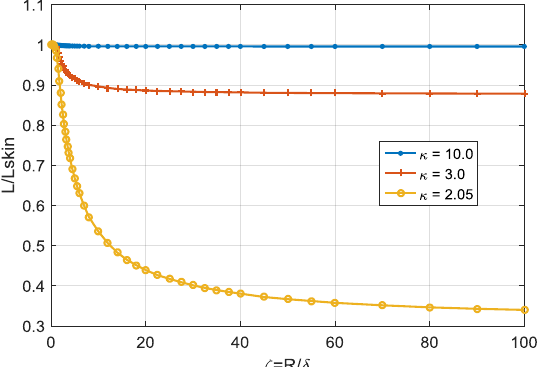
Figure 2: The final ratio 𝐿/𝐿 𝑠𝑘𝑖𝑛 in function of 𝜁 for 𝜅 = 10.0, 3.0, and 2.05 , in this order from top to bot-